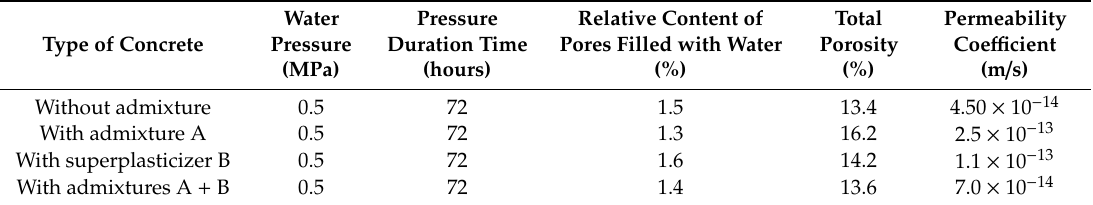
Table 4. Results of the permeability test (from the modified flow pump method at a constant level of hydraulic head).